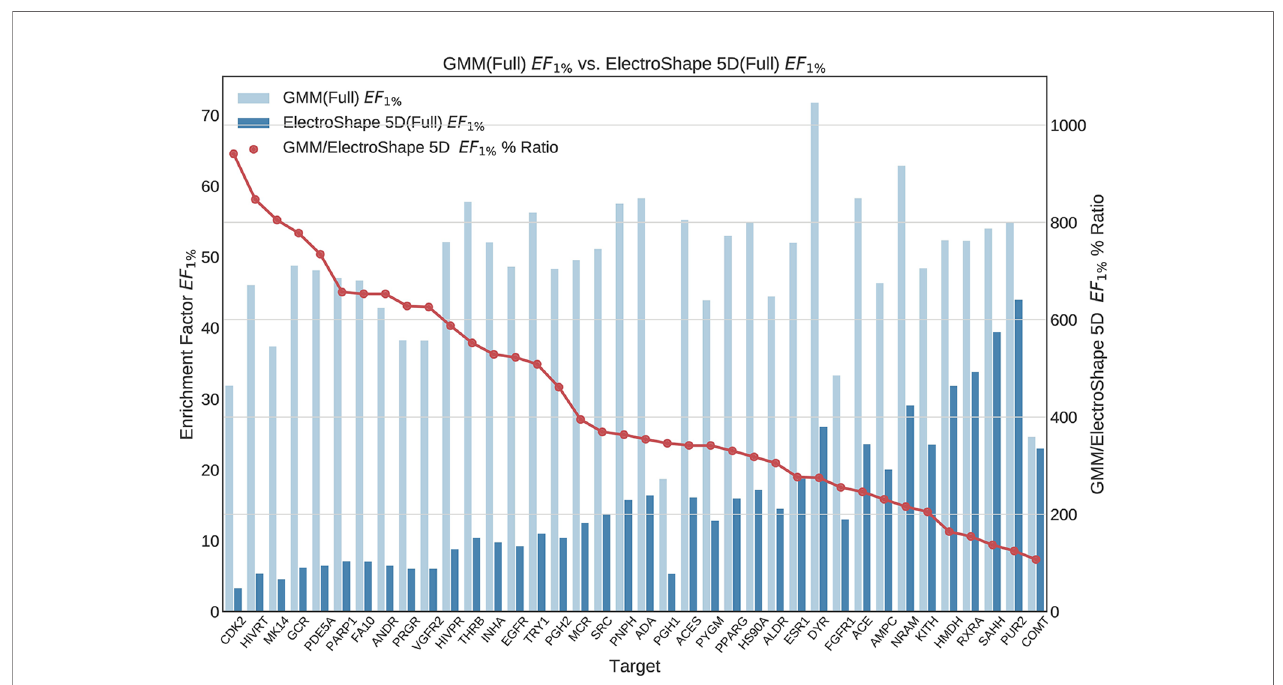
FIGURE 5 | Comparison of Enrichment Factor at 1% obtained by Gaussian Mixture Models with that obtained by ElectroShape 5D using full conformer model. Also plotted is the percentage ratio of the Enrichment Factor score of Gaussian Mixture Model (GMM) compared to ElectroShape 5D. Mean ratio = 430% ± 223%, max = 941%, min =